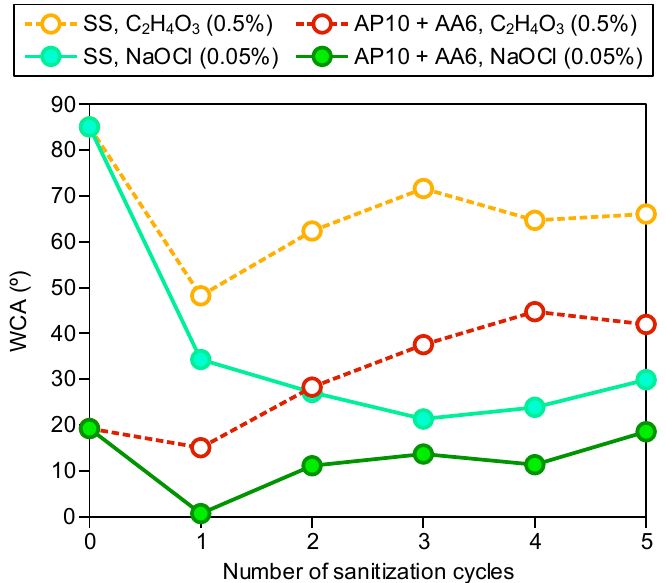
Figure 5. Evolution of the WCA of the uncoated SS and the coating AP10 + AA6 subjected to five sanitization cycles with peracetic acid (0.5%) and sodium hypochlorite (0.05%). The WCA values at zero sanitization cycles correspond to the non-sanitized surfaces.